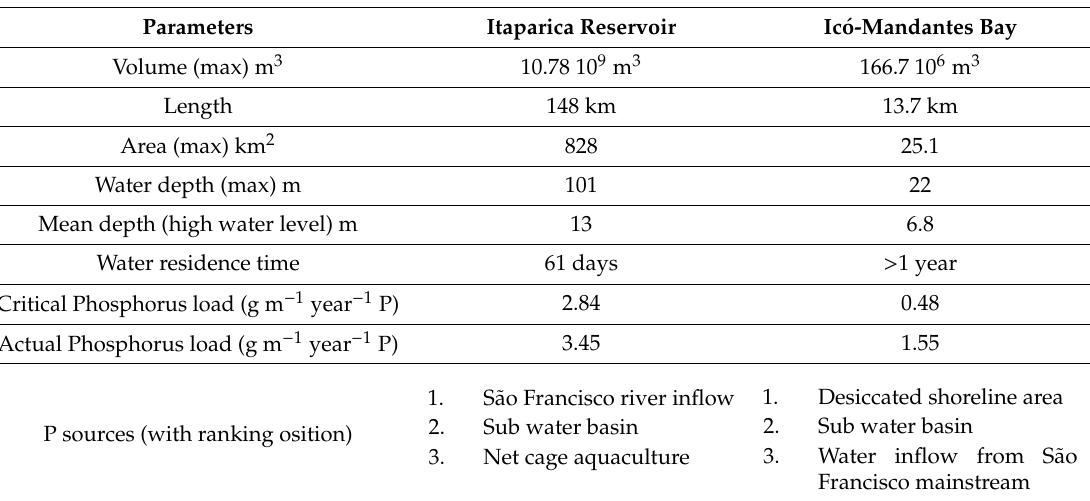
Table 3. Morphometric characteristics of Itaparica reservoir and Ic ó -Mandantes Bay and e ff ects of reduced water exchange in the Ic ó -Mandantes bay